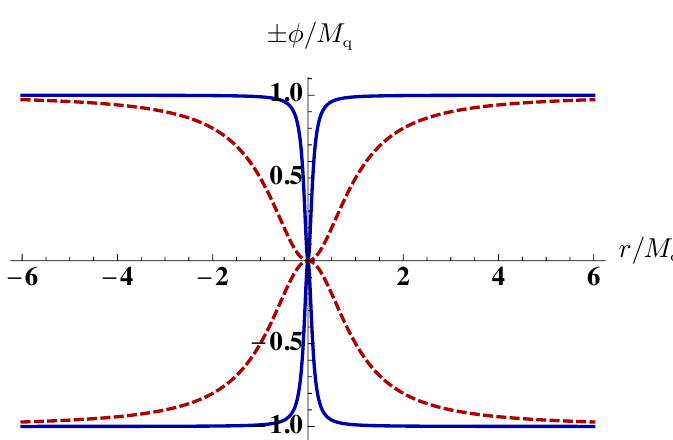
(dashed, red curve) q